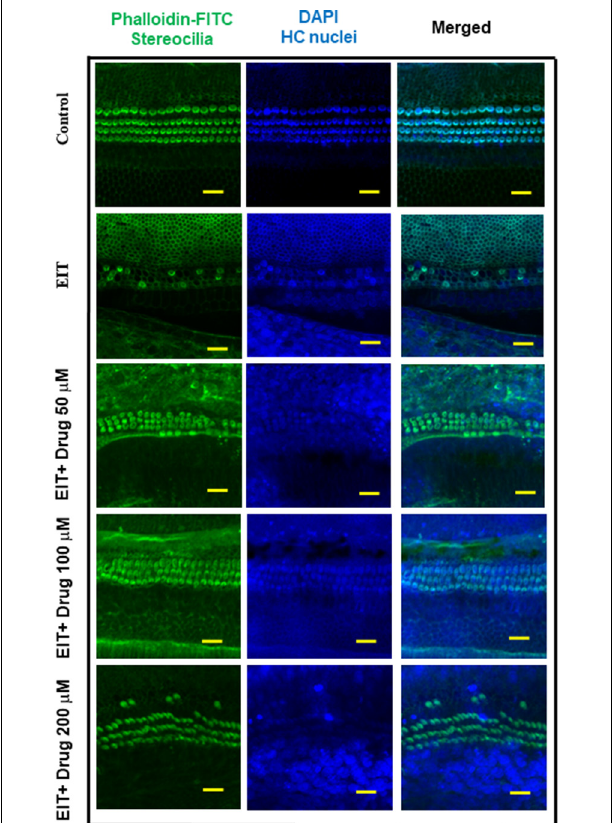
FIGURE 1 | Taurodeoxycholic acid (TDCA) prevents hair cell (HC) loss from electrode insertion trauma (EIT). Representative images of FITC-phalloidin stained HCs in organ of Corti (OC) explants exposed to EIT alone or exposed to EIT and treated with different concentrations of TDCA. Results are representative of three independent experiments. n = 6 OCs per group. Scale bars: 10 µ m.